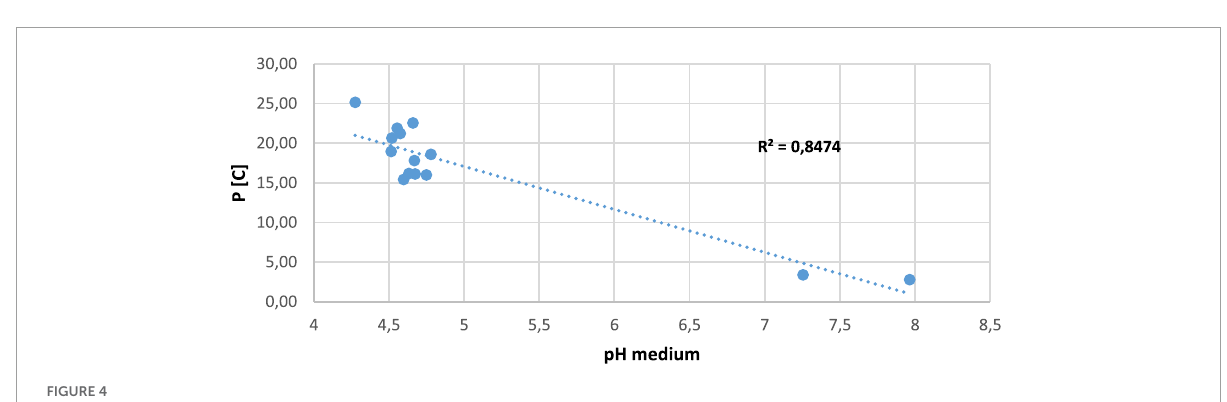
FIGURE3 PSBs solubilization capacity of TCP and RP after 7 days in liquid medium.